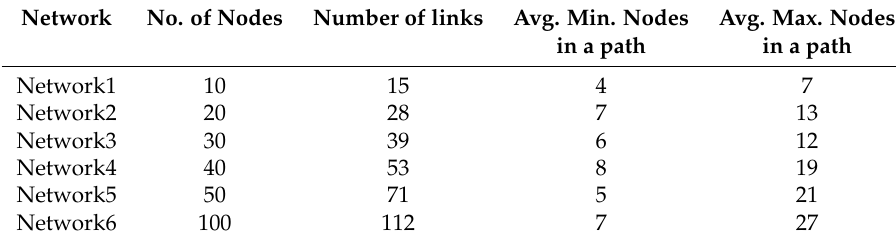
Table 4. Network configuration.